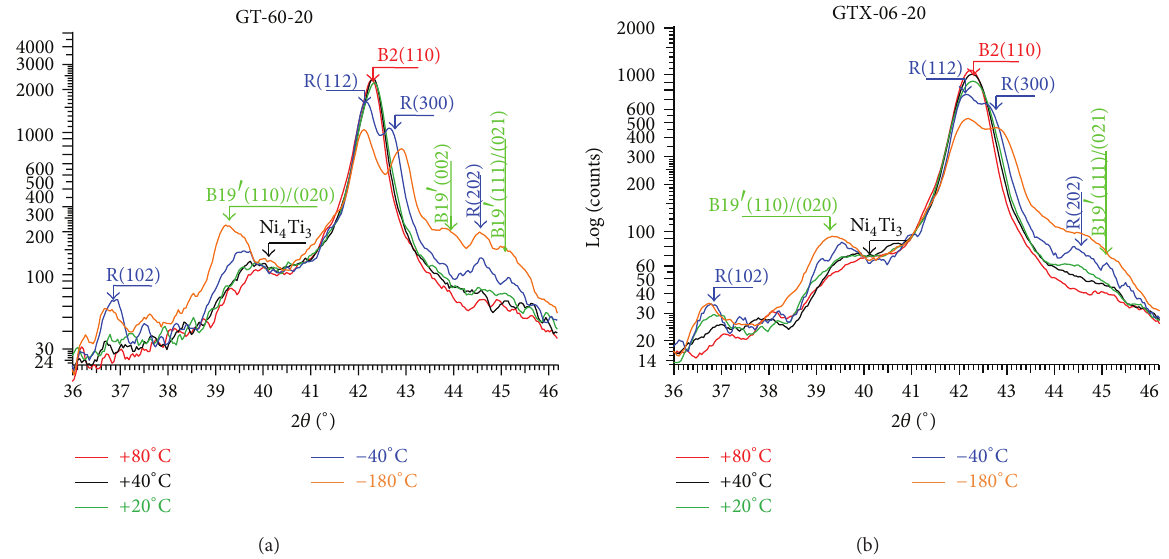
Figure 3: 3D XRD patterns during cooling of both GT and GTX files, with identification of the austenite (B2), R-phase, and martensite (B19 󸀠 ) peaks: a selection of 5 scans at +80, +40, +20, − 40, and − 180 ∘ C, and a 3D view of this selected group of scans is shown.